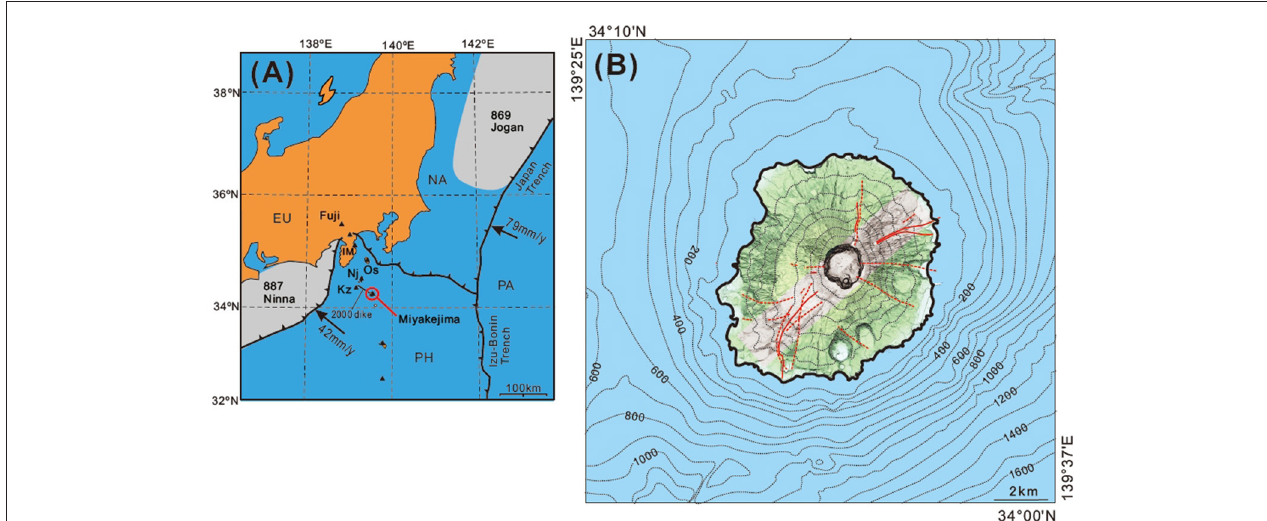
FIGURE 1 | (A) Tectonic setting of the Miyakejima Island. PH, Philippine Sea Plate; PA, Pacific Plate; NA, North America Plate; EU, Eurasia Plate Arrows indicate the direction and speed of the subduction at the trench. Solid triangles show the location of active volcanoes. IM, Izu-Tobu Monogenetic Volcanoes; Os, Izu-Oshima; Nj, Niijima; Kz, Kozushima. Gray areas show the approximate source area of the 869AD Jogan earthquake and the 887AD Ninna-Nankai earthquake. (B) Distribution of the eruption fissures. Solid red lines show the eruption fissure in the nineteenth and twentieth centuries. Historical records confirm their ages. Broken red lines show the eruption fissures younger than the seventh century. Their ages are suggested by the 14 C age. The shadowed area shows the approximate area of the NE-SW rift zone. Counters are 100m